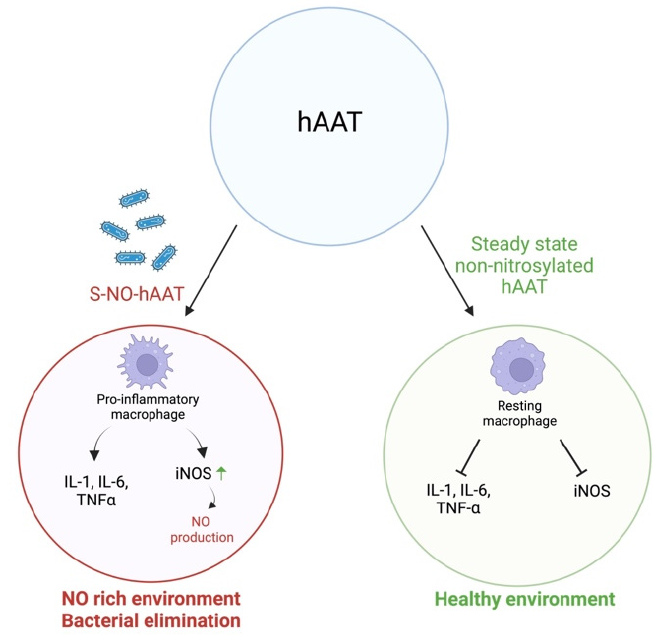
Figure 2. Divergence of hAAT functions between a sterile and a non-sterile environment . Upon exposure to macrophage-derived nitric oxide (NO), hAAT undergoes a covalent change to become S-NO–hAAT ( left ). S-NO–hAAT is inflammatory; activated macrophages increase pro-inflammatory cytokine release and iNOS expression, thereby promoting an antibacterial environment (created with BioRender.com).